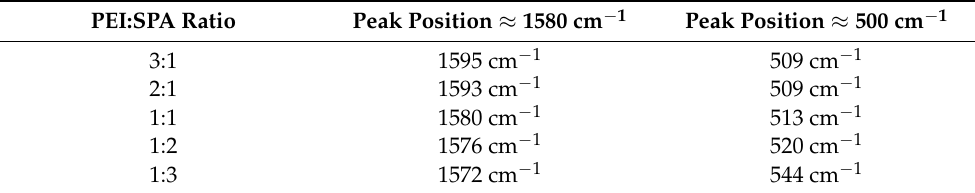
Figure 5. FTIR spectra of solutions of different PEI:SPA ratios after acidification. Table 2. Peak shifting depending on the PEI:SPA ratio.